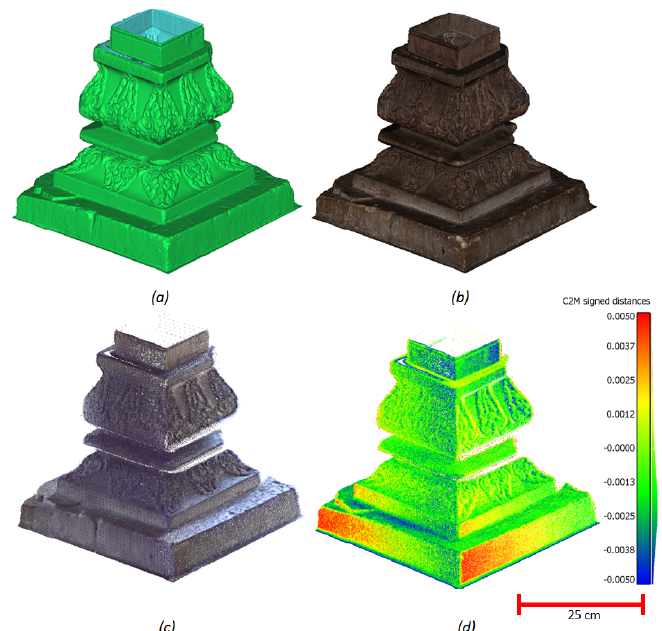
Figure 8. Results for the eastern upper plinth of the Royal Pavilion; the 3D mesh ( a ) and textured ( b ) models generated by photogrammetry were used as a reference against the TLS point cloud ( c ). In ( d ), the cloud-to-mesh distance analysis yielded a mean error of 1.5 mm and a standard deviation value of 2 mm.